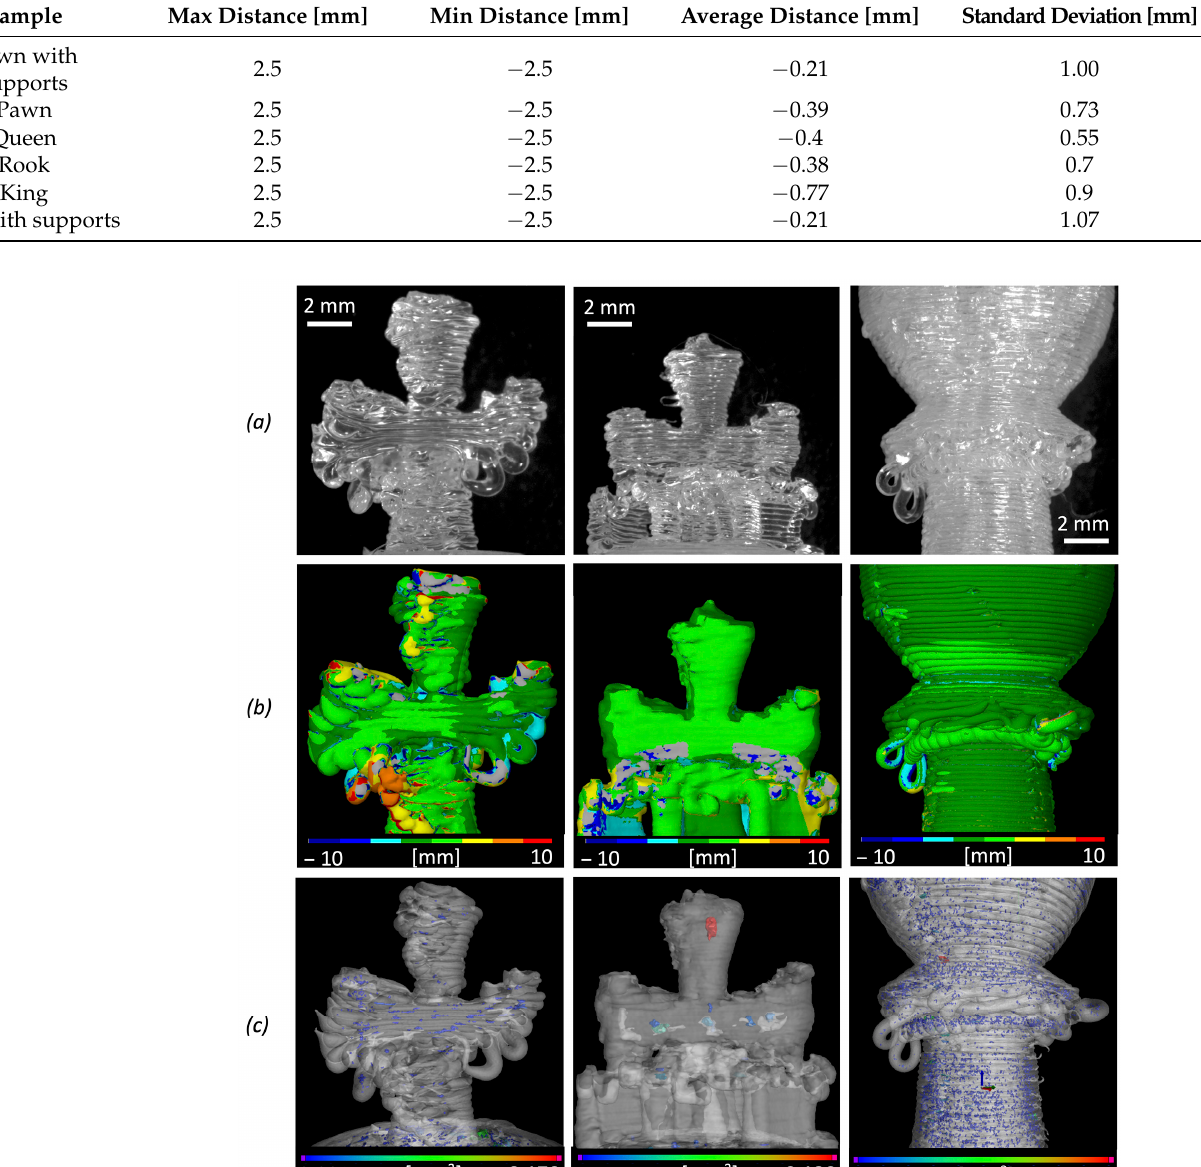
Table 8. Alignment results of 3D printed chess pieces.